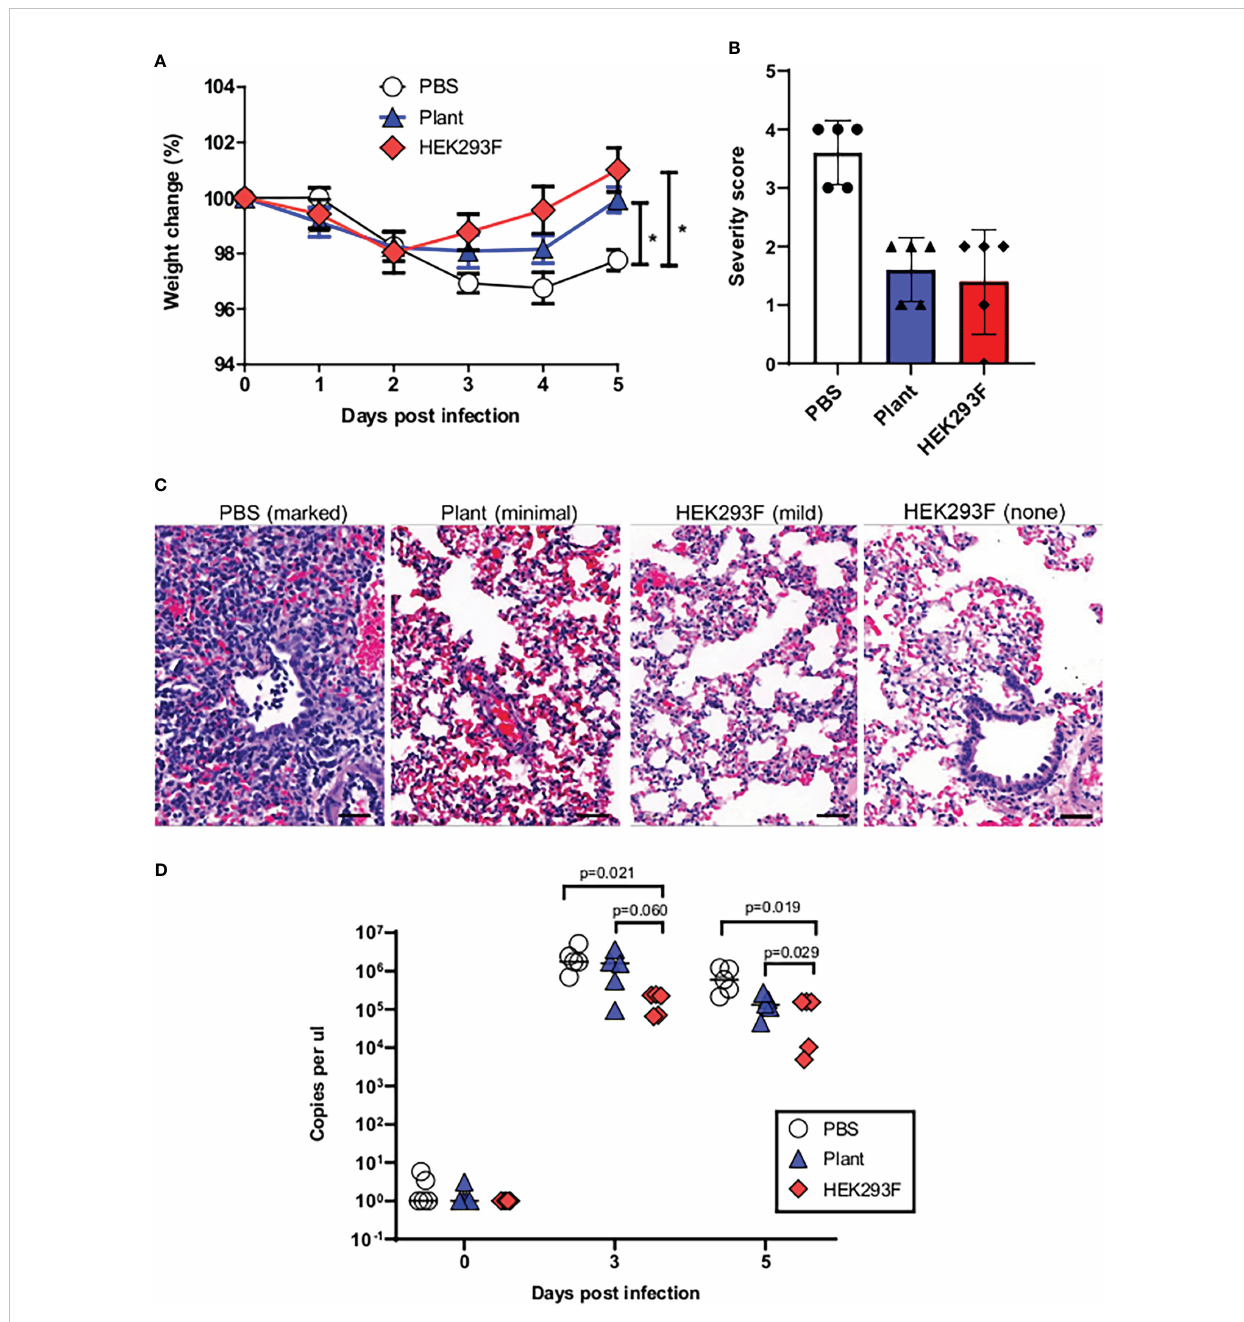
FIGURE 5 Vaccine-mediated protection against heterologous challenge. (A) Change in weight following experimental challenge. (B) Grading of lung pathology following challenge. (C) Representative images of histopathology fi ndings in lung sections. (D) Viral load following